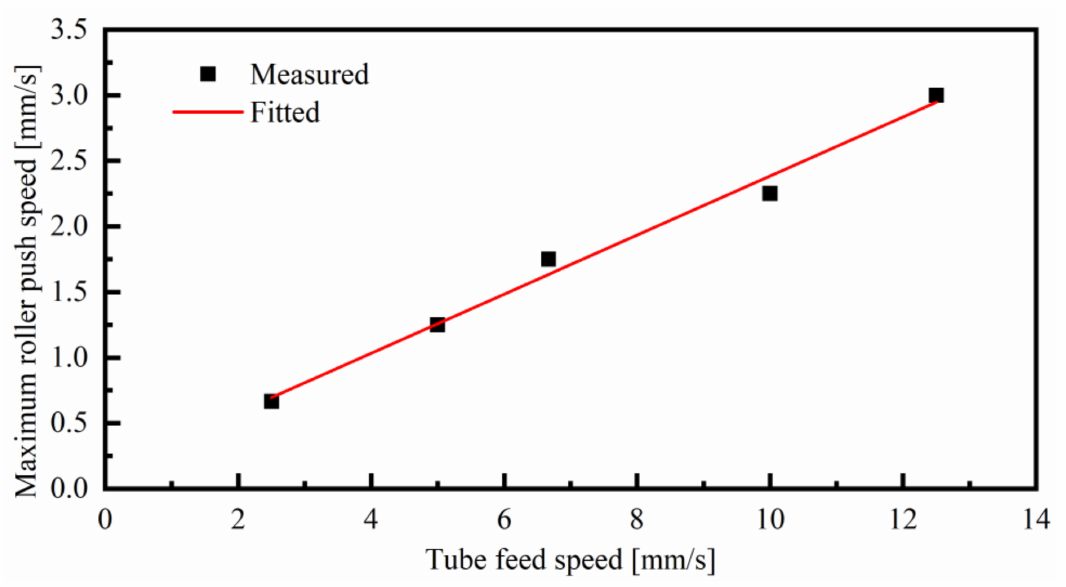
Figure 23. The relationship between the maximum push speed of the bending roller and the feed rate of the